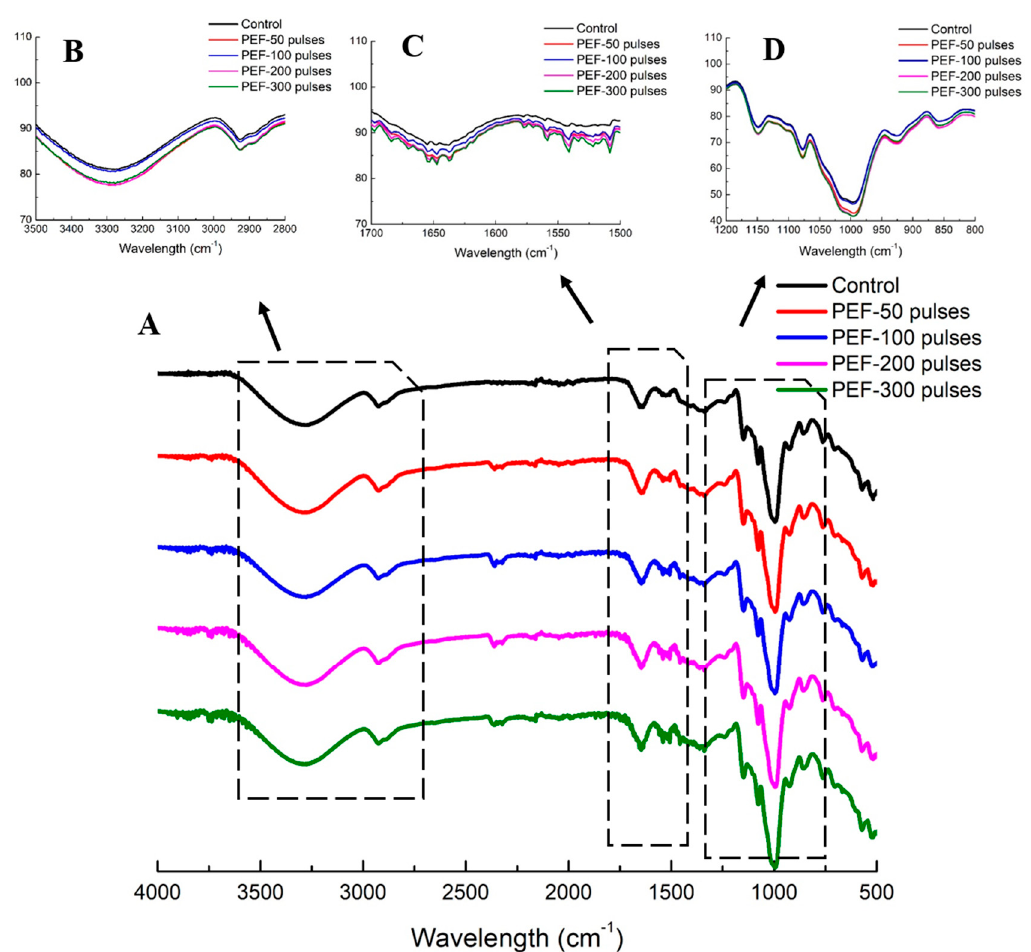
Figure 3. Separated and overlay Fourier transform infrared (FTIR) spectra ( A ) of control and PEF treated glutinous rice flour at the field strength of 3 kV/cm for 50, 100, 200 and 300 pulses. The overlay spectra have been zoomed to show the regions of 3500–2800 cm − 1 ( B ), 1700–1500 cm − 1 ( C ) and 1200–800 cm − 1 ( D ).